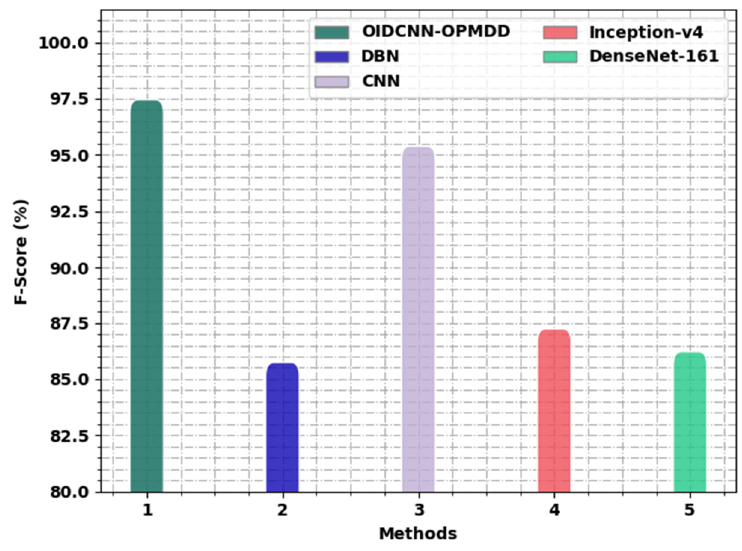
Figure 15. F_score analysis of OIDCNN-OPMDD approach with existing